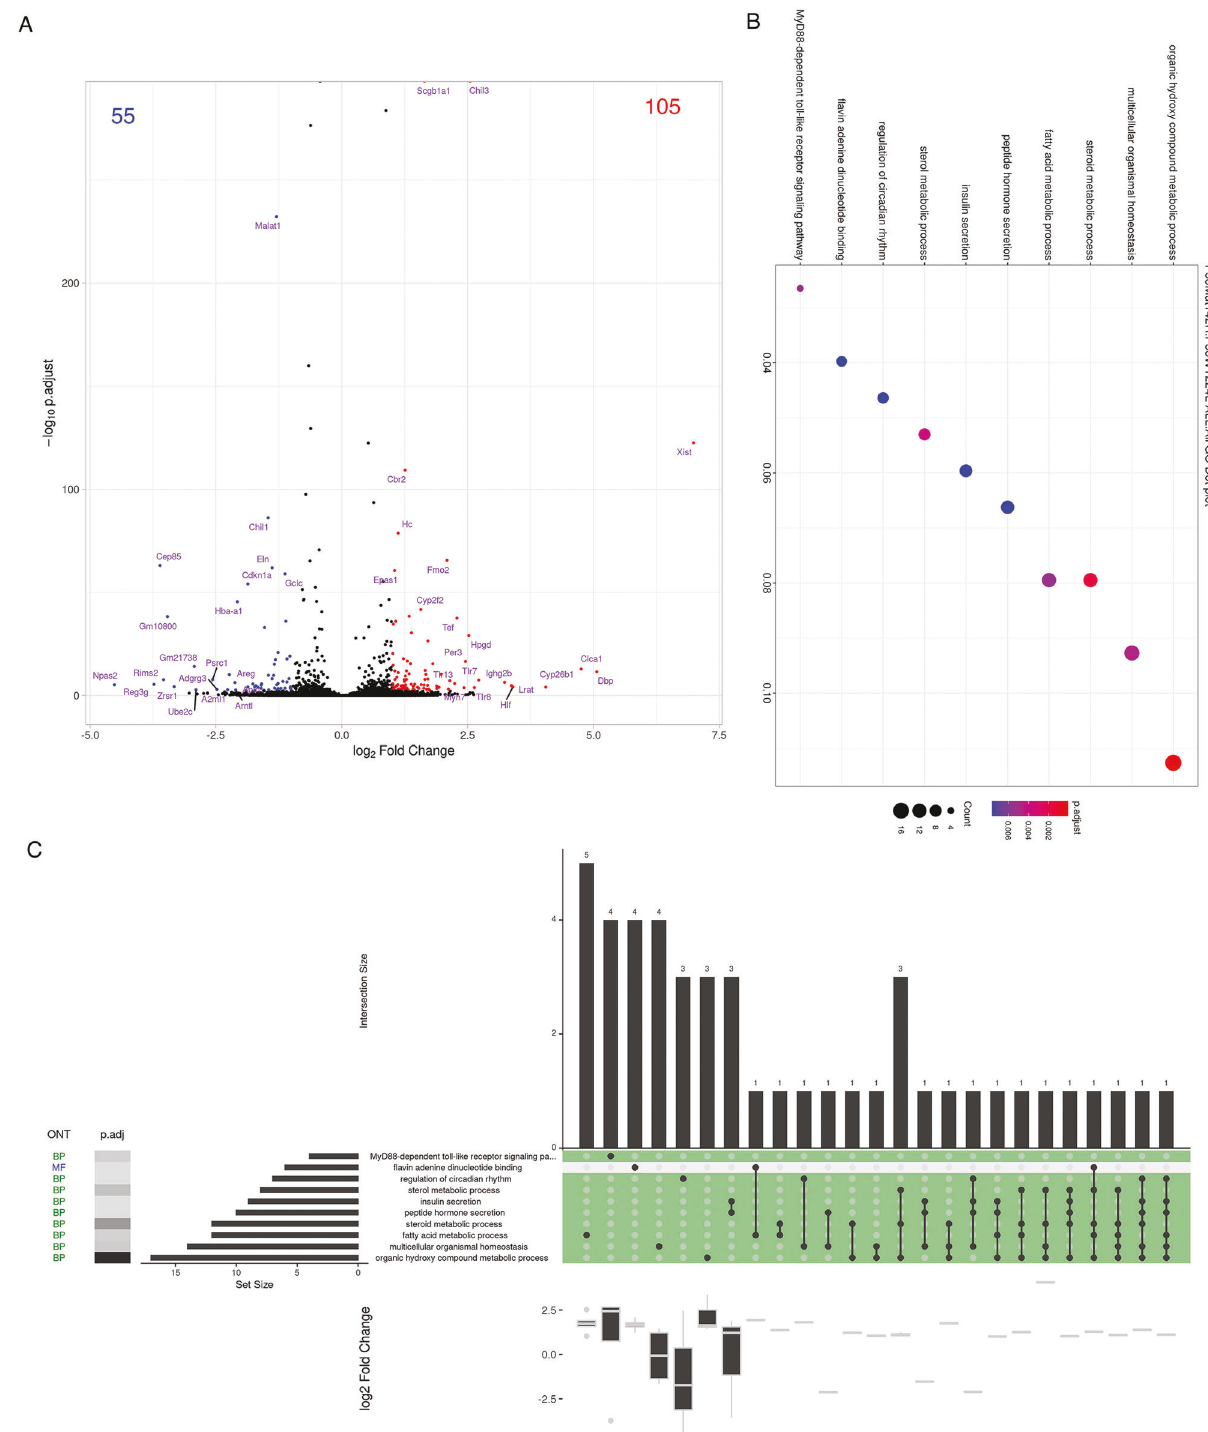
Fig. 8 Gene expression during drug resistance acquisition was regulated in a Tp53 + / + manner. mRNA samples isolated from lung tissues of drug-resistant mice with ( n = 1) or without Tp53 knockout ( n = 1) were used to study the gene expression by RNA-seq. The gene changes in drug-resistant mice with or without Tp53 knockout were studied by generating a DEG plot/volcano plot ( A ). The p53-mediated pathways during drug resistance acquisition were analyzed by generating a GO dot plot ( B ). Enriched intersecting pathways were analyzed by generating by a GO UpSet plot ( C ). therapeutic periods also promote tumor heterogeneity through chromosome 1 and chromosome 11 in a Tp53 + / + and Tp53 + / − an increase in genomic instability, thereby inducing drug manner respectively, during drug resistance acquisition. resistance [30]. Tumor heterogeneity can be classi fi ed as intra- Tumor heterogeneity develops during cancer progression from tumoral (within a tumor) or intertumoral (between tumors) [31]. initiation to malignant transformation [29]. Furthermore, Cell Death Discovery (2023)